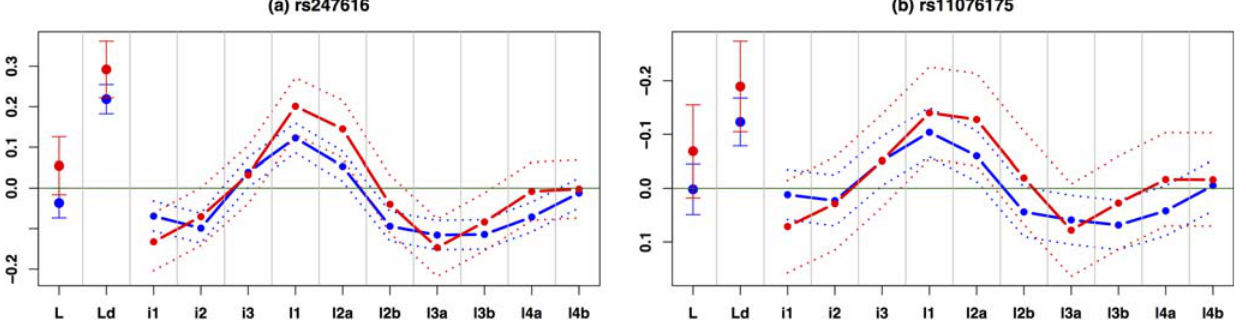
Fig 3. Replication of two independent associations in CETP (top SNP rs247616 and secondary SNP rs11076175). Dashed lines show estimated effect sizes on (normalized) phenotype for each subfraction in our study (red) and JUPITER (blue); dotted lines show ± 2 standard errors. Note that, the y-axis is reversed for the secondary SNP as in Fig